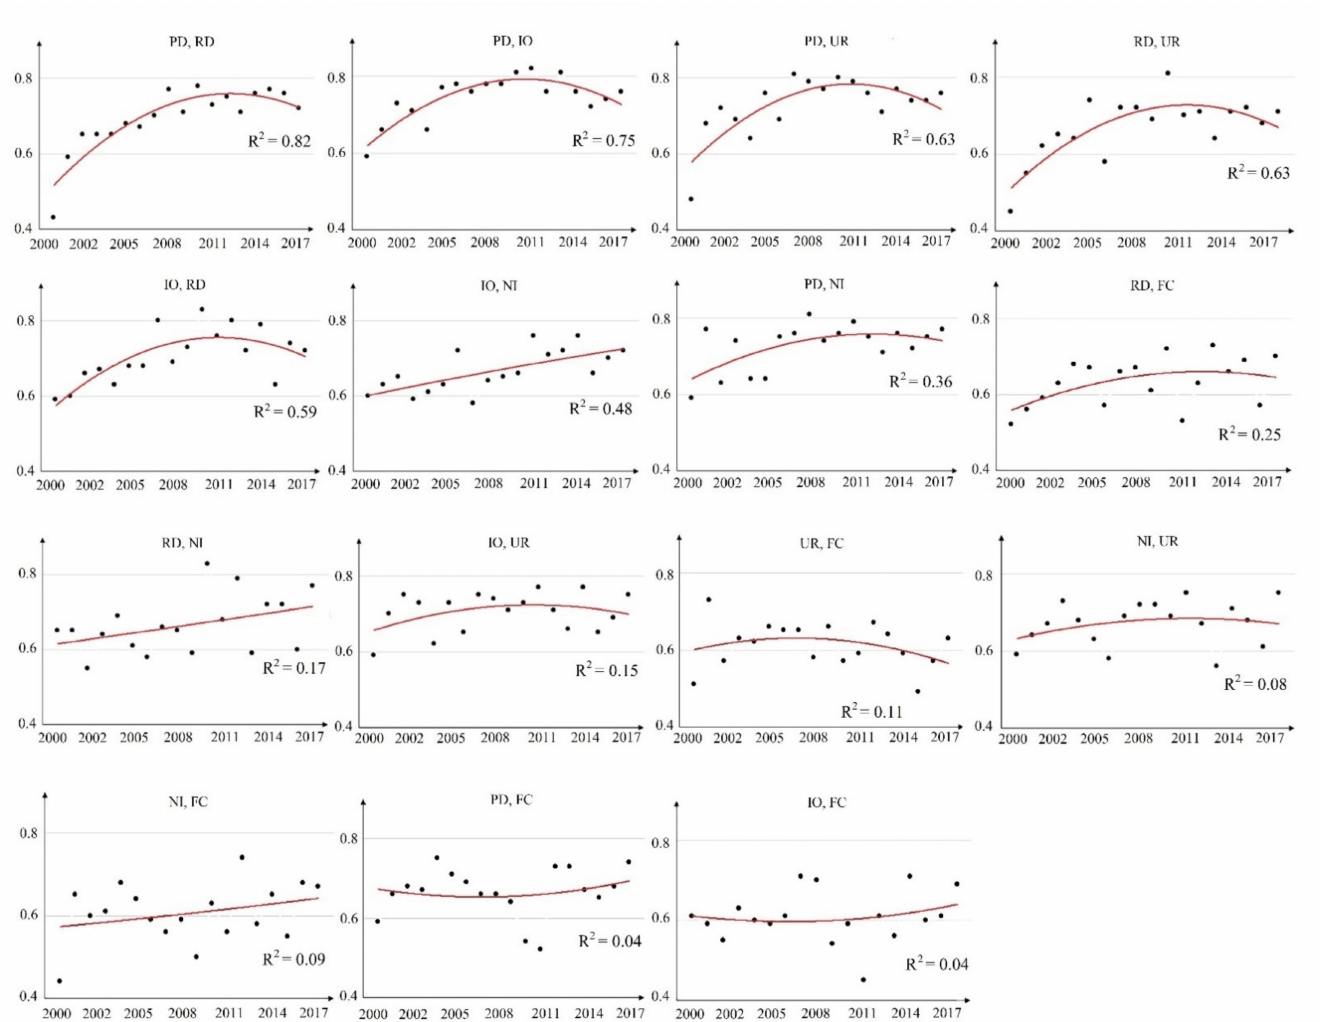
Figure 8. Scatter plots with trend lines of q values for each pair of interactive effects from